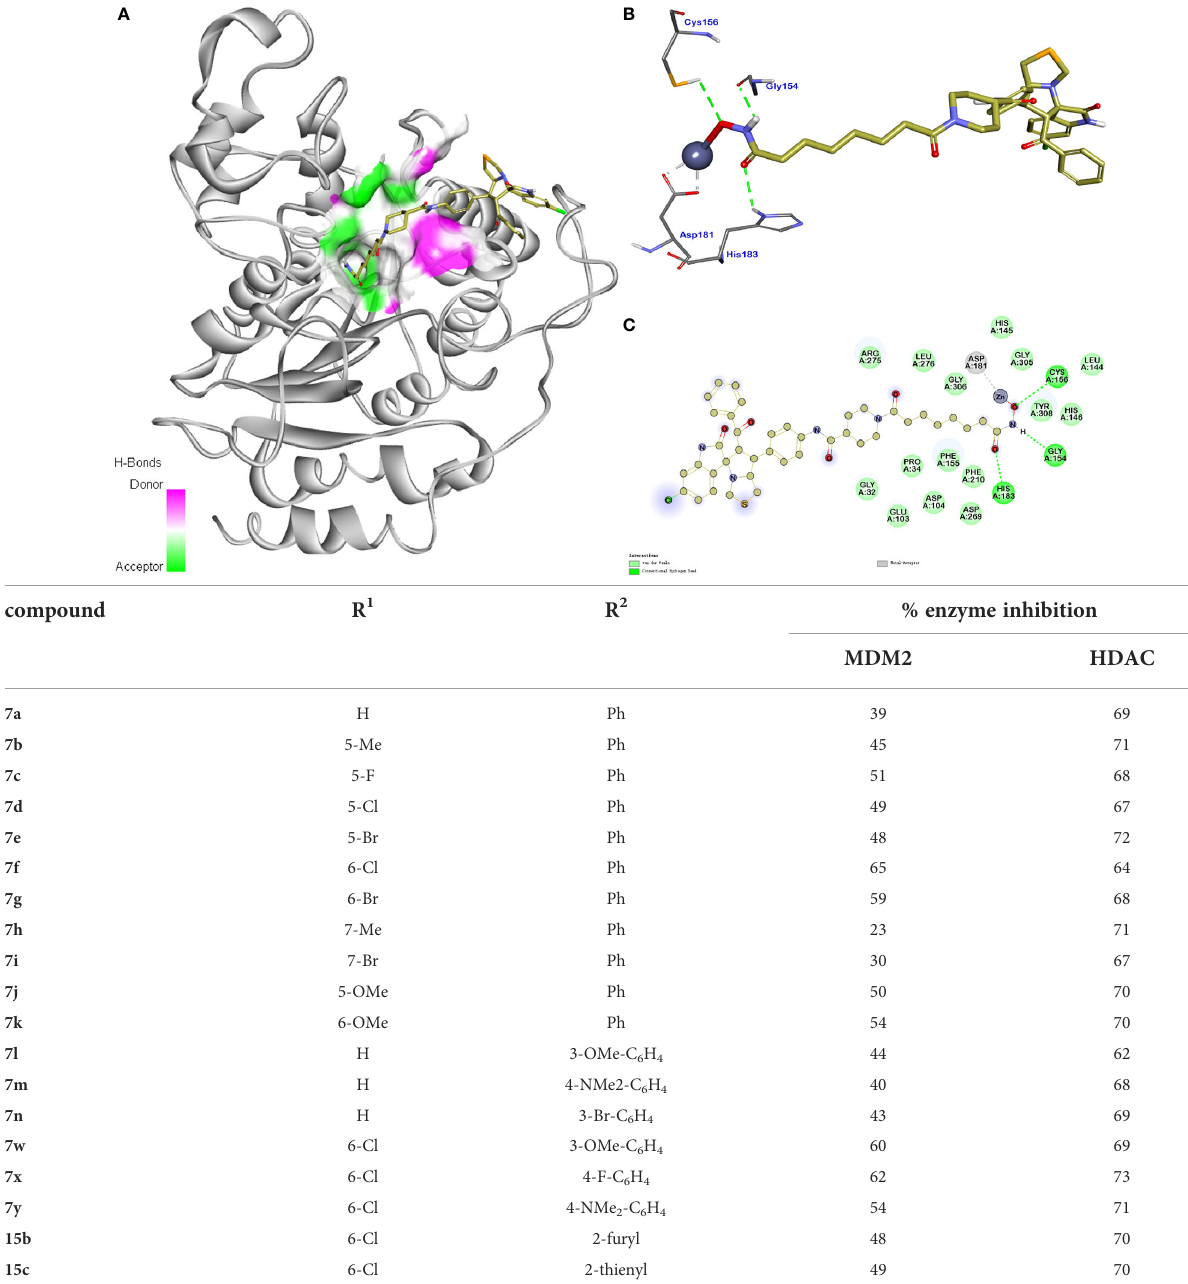
TABLE 1 Effects of substituted group R 1 and R 2 on enzyme